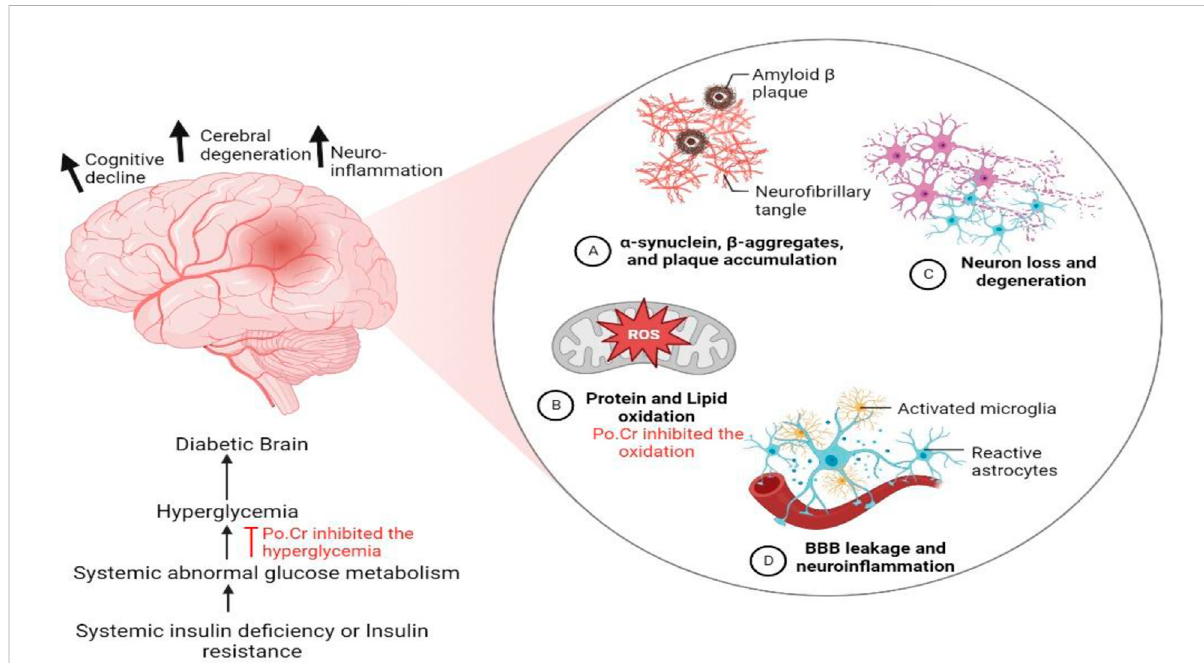
FIGURE 8 Illustration explaining the possible mechanism of development of cognitive impairment and dysfunction associated with diabetes mellitus. The long-term administration ofcrude extract of Plumeria obtusa L.not only reduces bloodglucoselevel but also reduces oxidative stressand therefore prevents diabetes-associated neuroin fl ammation and cognitive